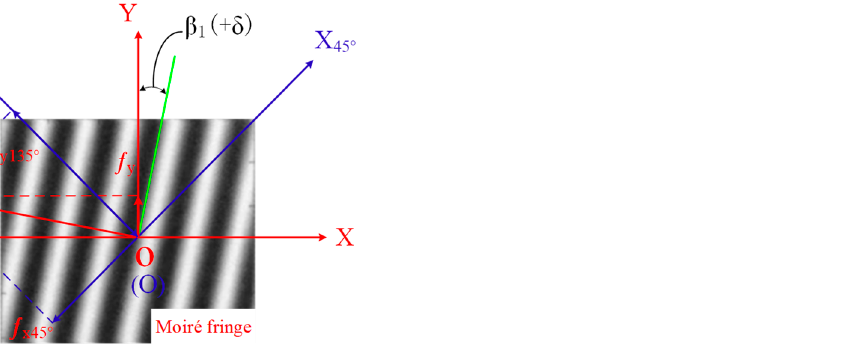
Figure 5. Space–frequency decomposition method (SFDM) for correcting angular displacement in plane.